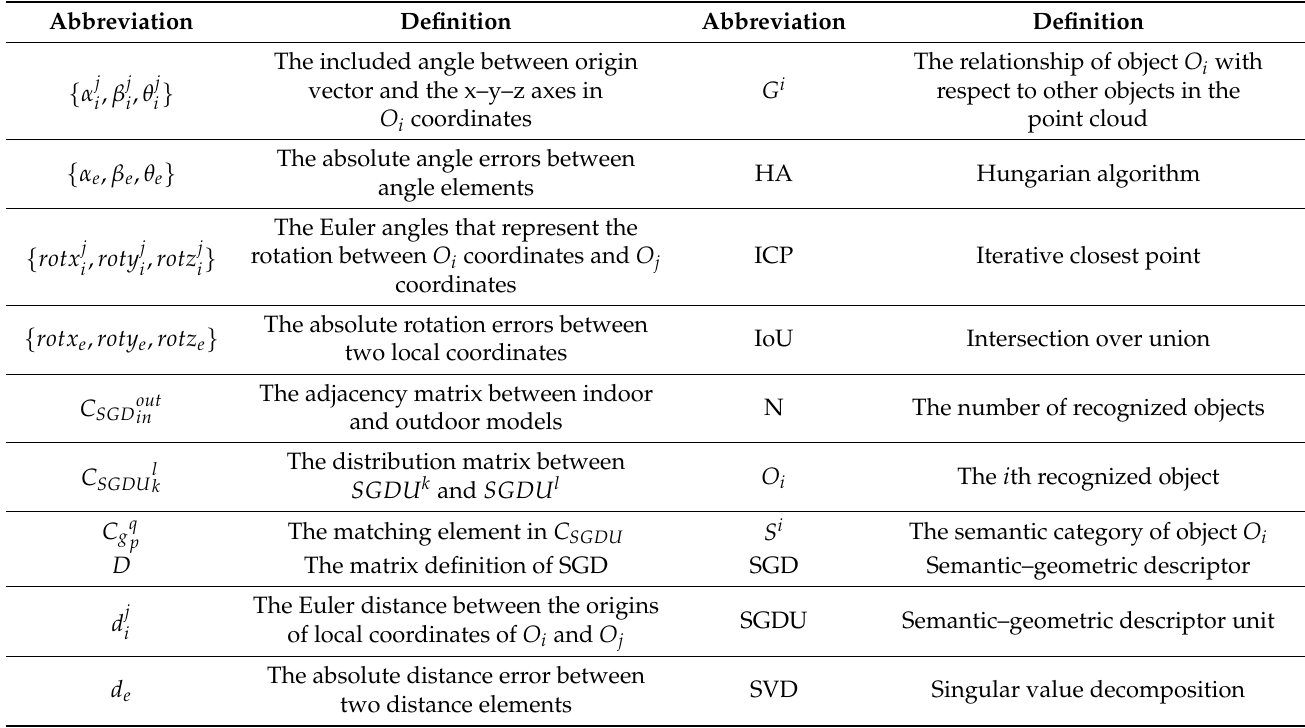
Table 1. List of important abbreviations and symbols used in the